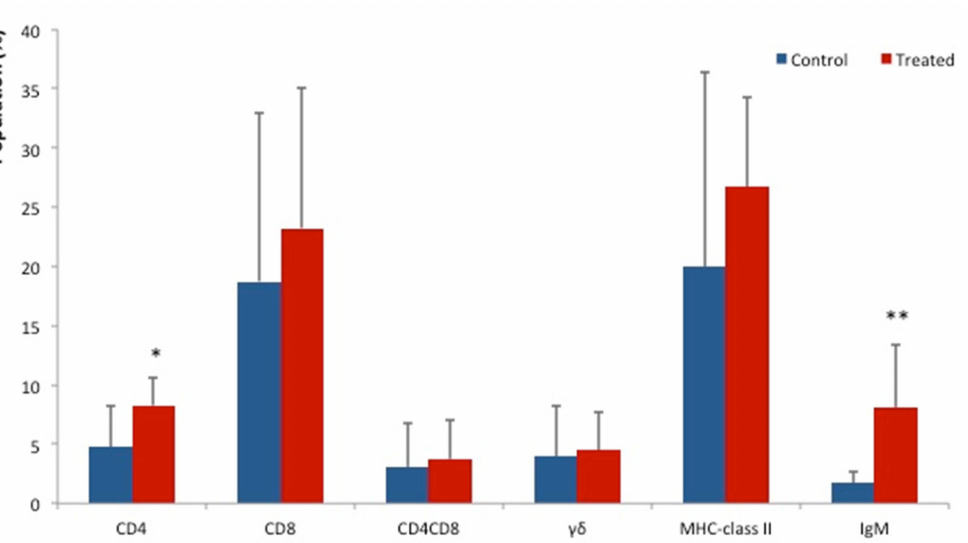
Figure 2. Immunostimulatory effects on the liver of BT-fed piglets. The populations of CD4 + cells and IgM + cells in BT-fed piglets ( n = 10) were significantly higher than those of control piglets ( n = 7). The populations of CD8 + , CD4+CD8 + , γδ + and MHC class II + cells isolated from the livers of BT-fed piglets were also increased. Values represent the mean ± SD. * p < 0.05, ** p < 0.01, compared to